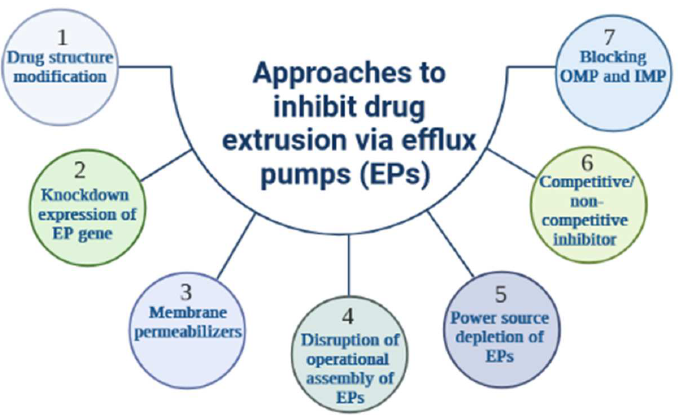
Figure 4. Approaches to counteract drug extrusion via efflux pumps. Several approaches to inhibit drug extrusion via efflux pumps (EPs) are described. Modification of drug structure results in a defect in drug recognition by EPs (1), whereas down-regulation of EP gene expression reduces EP activity and increases intracellular drug concentration (2), the latter also being achievable by the action of membrane permeabilizers (3). Some inhibitors can disrupt the functional assembly of EPs, thereby altering the efflux machinery (4). Since all EPs are sensitive to their energy source, a shutdown would significantly affect the energy level and subsequently reduces drug efflux (5). Competitive as well as non-competitive blockers have also been used (6) and they specifically block drug extrusion channels (7). In addition, some inhibitors can target the OMP (outer membrane protein) and IMP (inner membrane protein) of RND